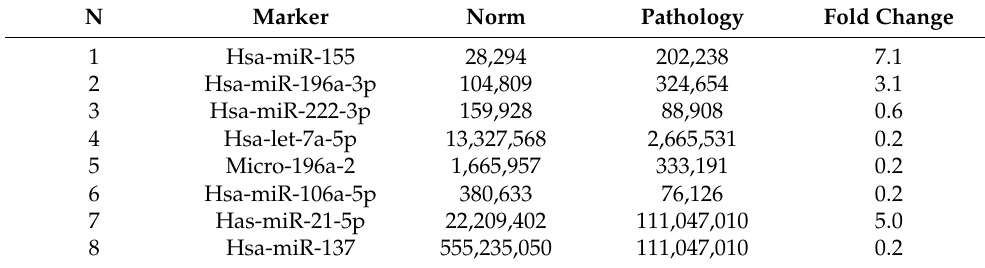
Table 1. miRNA expression at the initial investigation in patient P. Changes in the quantitative indicators (copies/ µ L) between “Norm” and “Pathology” of 1.5–2 times indicate a slight increase (risk factor = 1), 2–5 times indicate a moderate increase (risk factor = 2), and 5 times or above indicate a significant increase (risk factor = 3). The threshold for each miRNA was determined by precedent statistics from literature. Concentration values are presented as log base 2 miRNA (copies/ µ L).